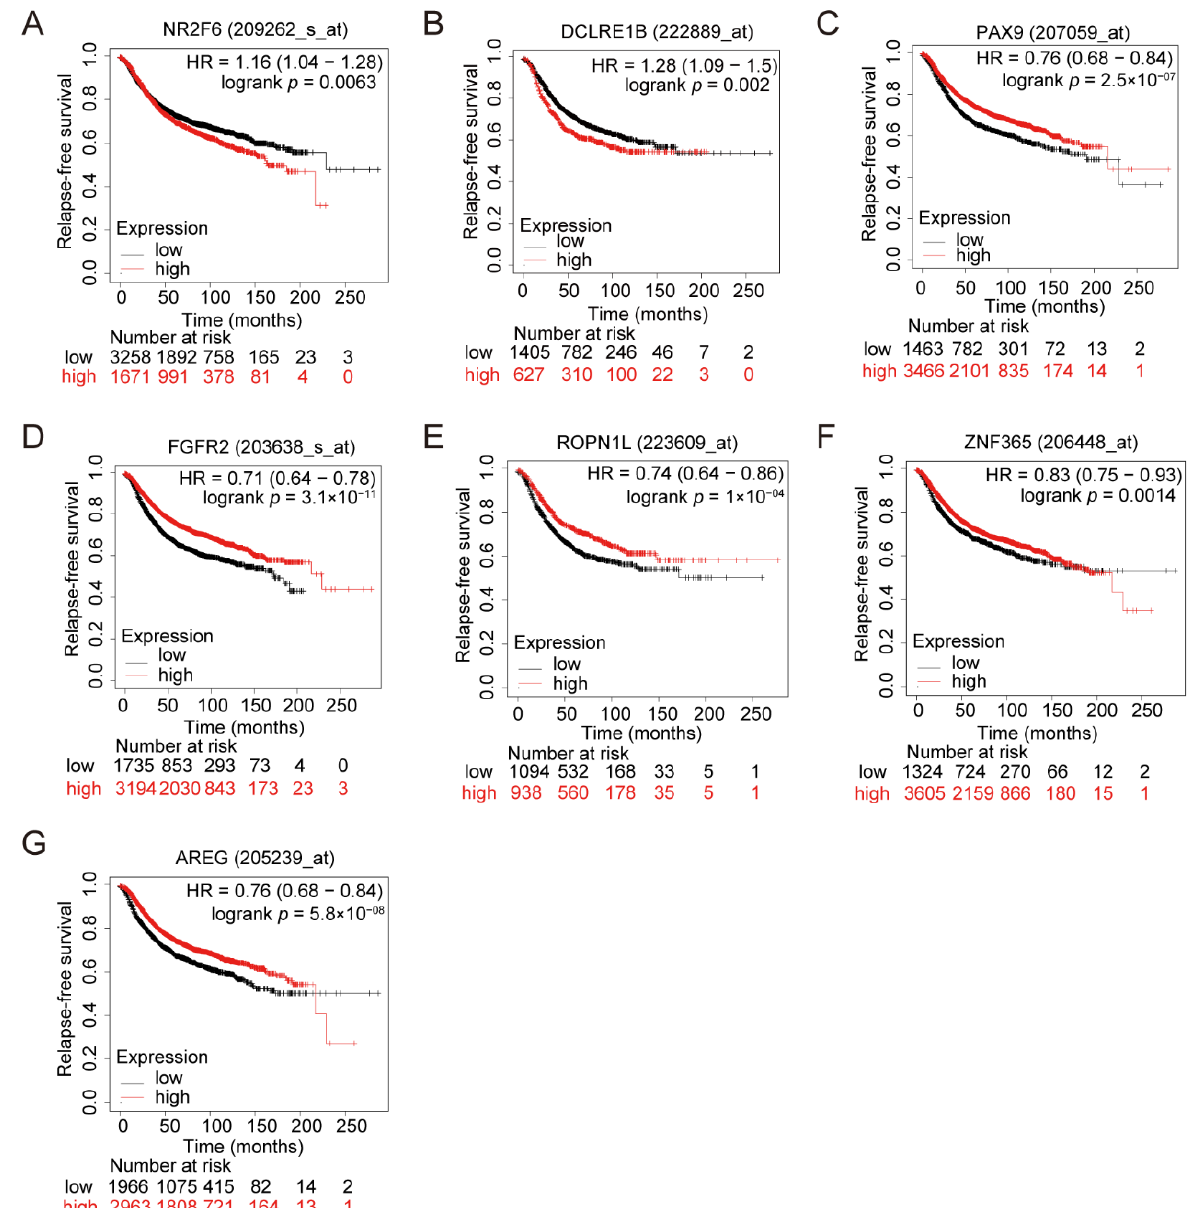
Figure 4. Effect of the seven risk SNP ‐ related genes on patient prognosis. ( A – G ) Kaplan–Meier Survival analysis showing the relapse ‐ free survival of breast cancer patients from GEO and EGA (European Genome ‐ phenome Archive), stratified using the auto ‐ select best cutoff for the expression level of NR2F6 ( A ), DCLRE1B ( B ), PAX9 ( C ), FGFR2 ( D ), ROPN1L ( E ), ZNF365 ( F ) and AREG ( G ). The hazard ratio for cancer relapse was provided with 95% confidential intervals, and p values were calculated with the log ‐ rank test.